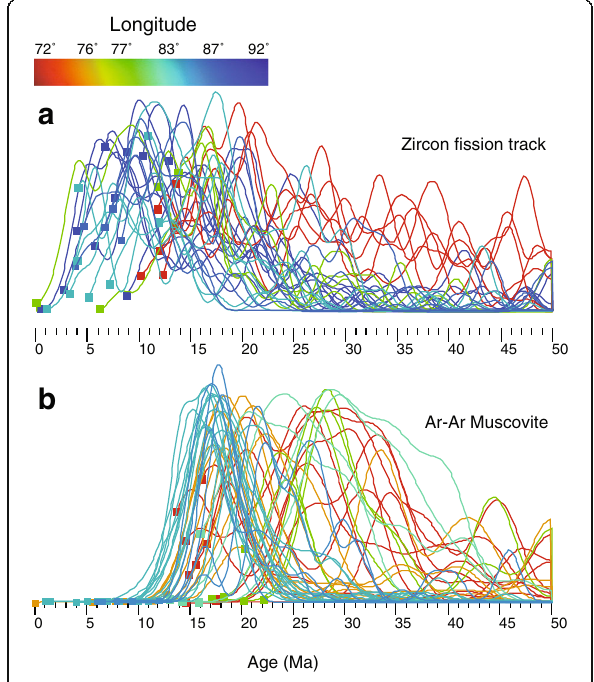
Fig. 9 Compilation of detrital thermochronology results from the Himalayan foreland basin, modified from Webb et al. (2017). Detrital thermochronology involves sampling sedimentary materials and acquiring cooling ages from detrital components, in order to constrain the cooling history of the sediment source regions. In parts a and b , 40 Ar/ 39 Ar muscovite and zircon fission track zircon results are plotted, respectively, for dates younger than 50 Ma. 40 Ar/ 39 Ar muscovite ages date the cooling of muscovite crystals below 425±25 °C (Harrison et al. 2009), whereas fission track zircon ages date the cooling of zircon crystals below 240±30 °C (Hurford 1986; Bernet and Garver 2005). The data are shown using the Kernel Density Estimation (KDE) methodology, which plots the detrital dates as a set of Gaussian distributions (Vermeesch 2012). This approach allows the age ranges and abundances of different detrital age populations to be compared: peaks in the curves represent peaks in the detrital age populations. For these plots, the population for a single sample is shown as a curve, sample longitude is keyed to a color spectrum, and the depositional age is shown via the squares at the young (left) terminations of the curve. These data provide an approximation of the cooling experienced by adjacent Himalayan regions. Signals in the Himalayan foreland basin can be complicated by river sediment transport along the range trend, since not all river systems transport sediment perpendicularly away from the mountains and thus might not only represent cooling and exhumation over the limited extent of the range immediately adjacent to the sampling location. A general trend appears in these data: peaks in the cooling age populations appear to young to the east from 25 to 20 Ma to 10 – 8